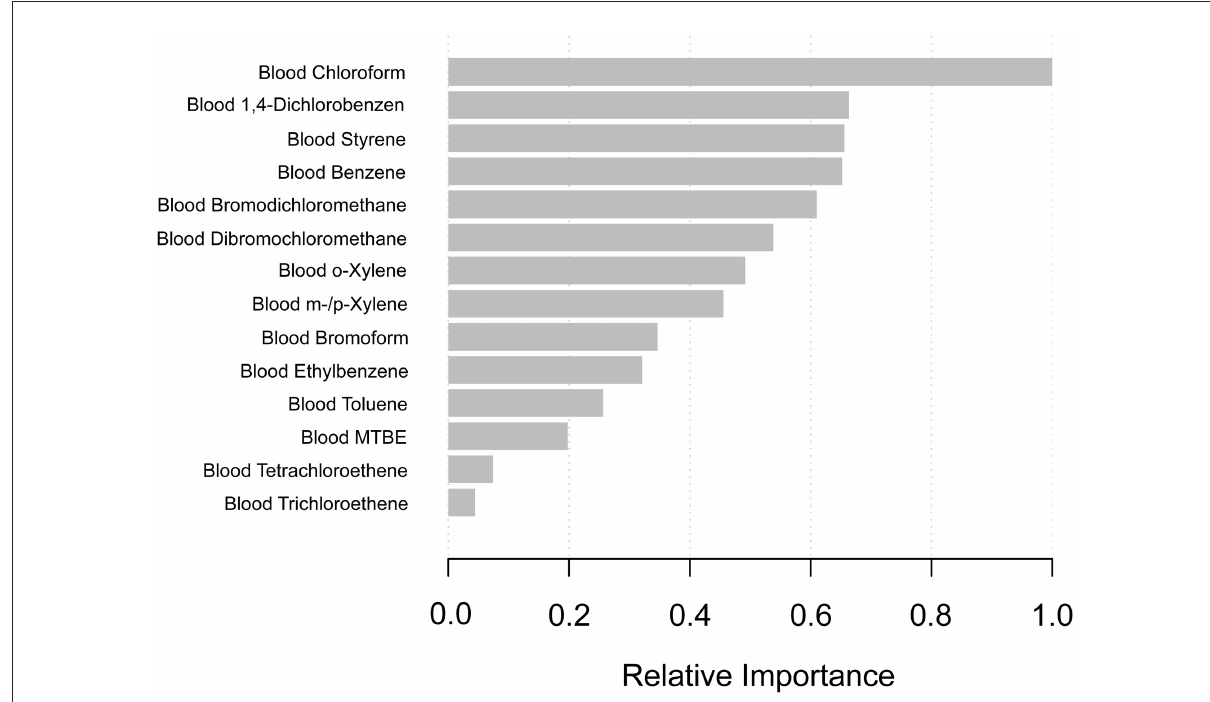
FIGURE2 XGBoost model reveals the relative importance of blood VOCs on the PSA concentration and the corresponding variable importance score. The X-axis indicates the importance score, the relative number of a variable used to distribute the data; the Y-axis shows the blood VOCs.